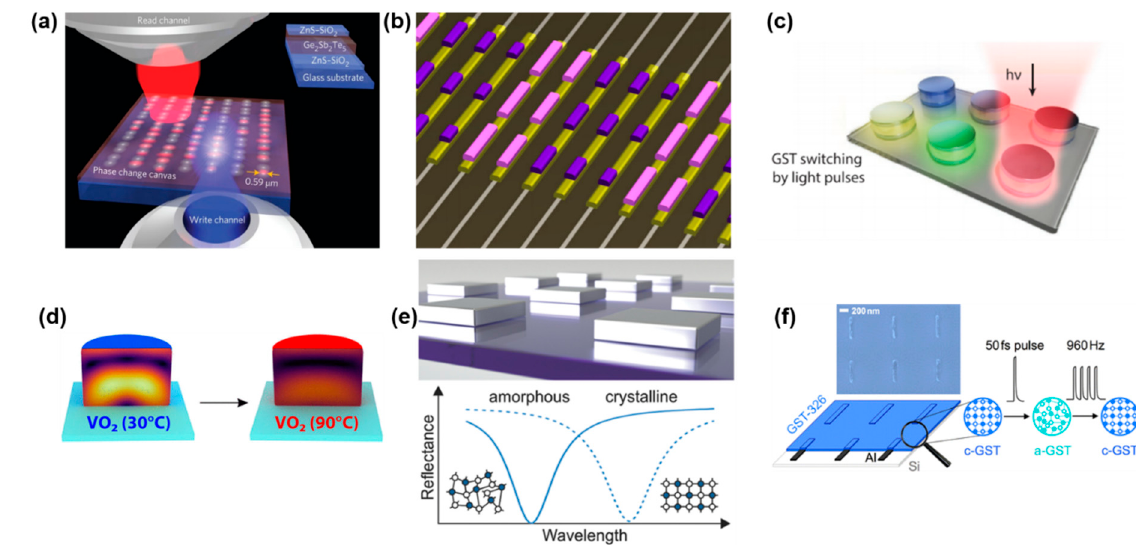
Figure 13. Integration of PCMs within photonic nanostructures. ( a ) Reconfigurable planar thin-film metasurface. Repro- duced from [76] with permission from Nature Springer. ( b ) Reconfigurable metasurface based on GST rods. Reproduced from [77] with permission from Wiley. ( c ) Reconfigurable metasurface based on Ge-GST meta-atoms. Reproduced from [78] with permission from Wiley. ( d ) VO 2 -based nanoantennas for metasurfaces in the visible. Reproduced from [79] with permission from the American Chemical Society. ( e ) Tunable perfect absorber based on metal-GST-metal resonances. Re- produced from [80] with permission from Wiley. ( f ) Plasmonic antennas switched with a PCM. Repoduced from [81] with permission from the American Chemical Society.